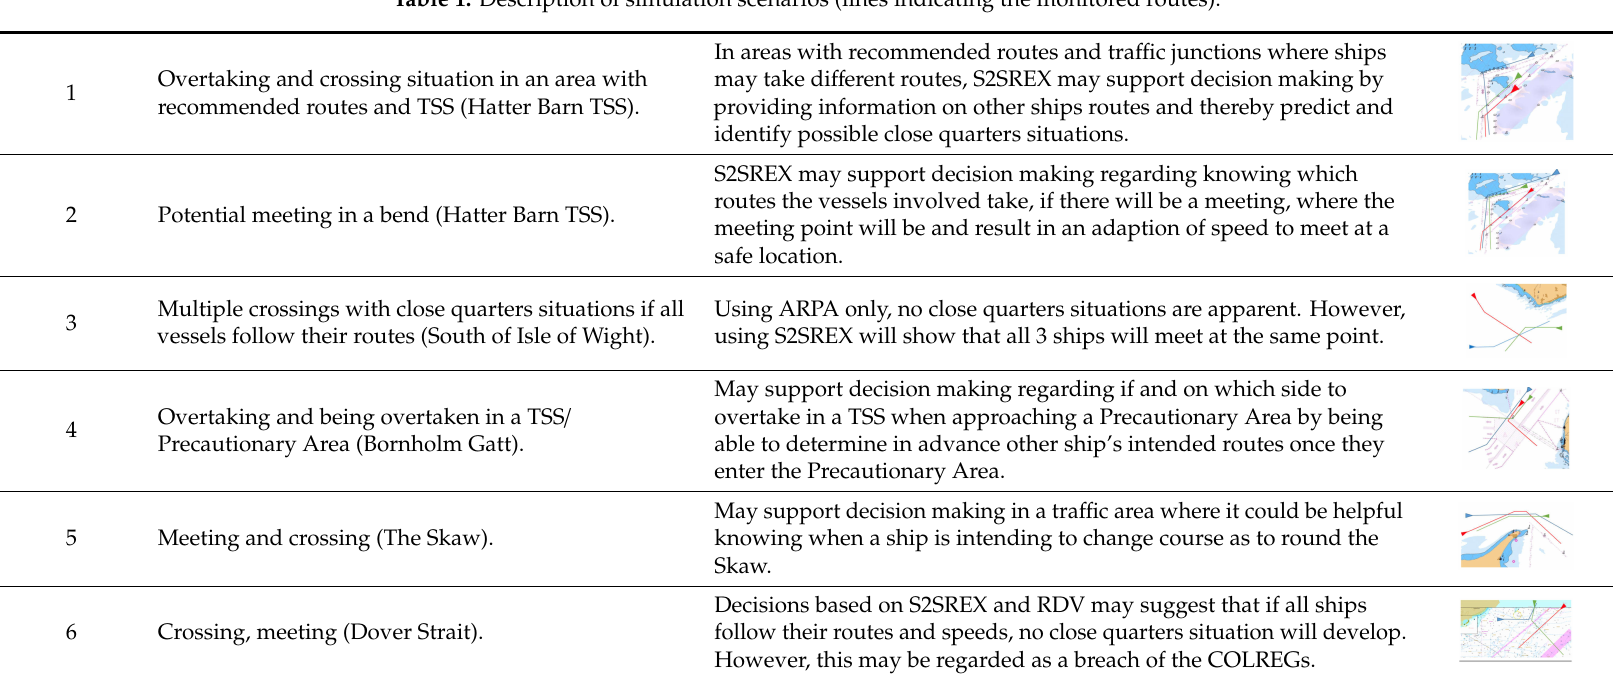
Table 1. Description of simulation scenarios (lines indicating the monitored